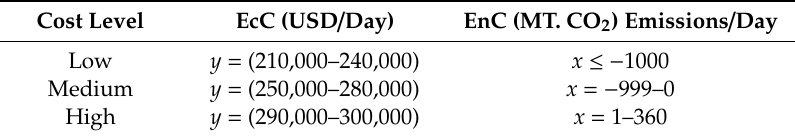
Table 3. Classification guide for the selection of acceptable